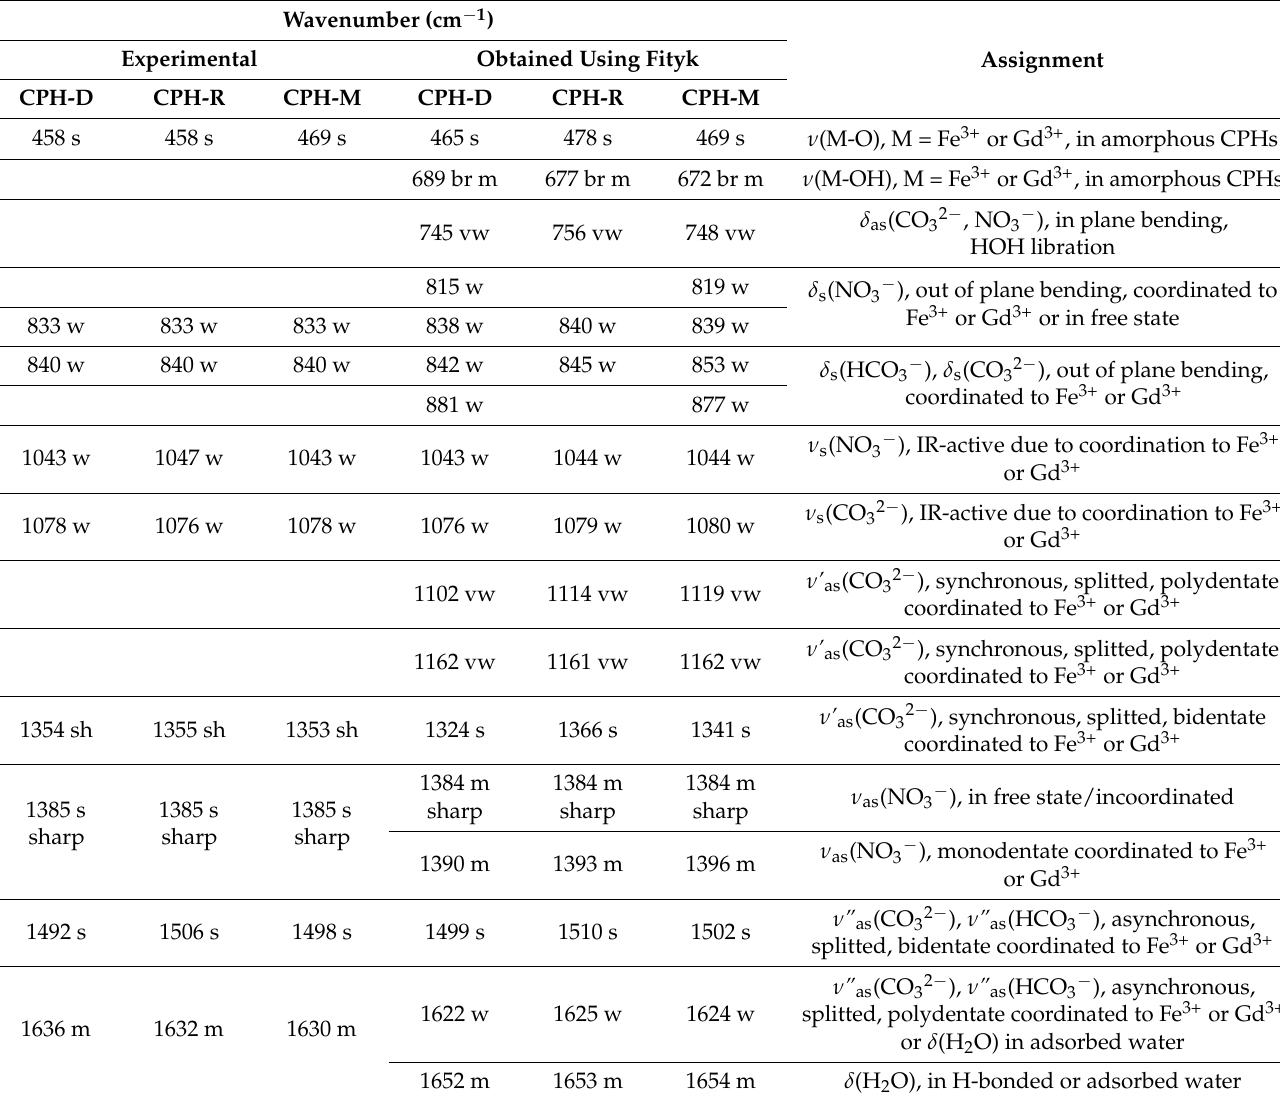
Assignment Experimental Obtained Using Fityk